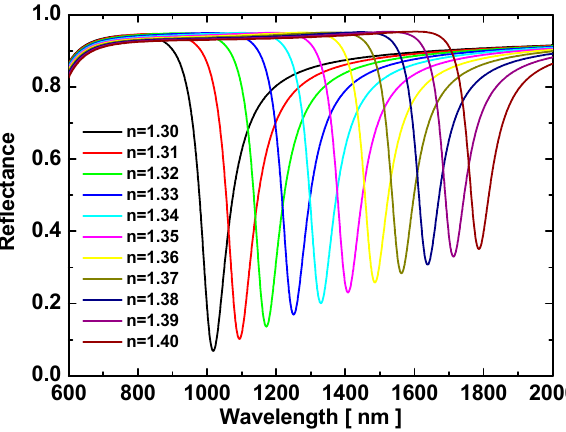
Figure 2. Reflection spectra of the AMDW structure for various refractive indices and for a fixed angle of incidence of 60°.